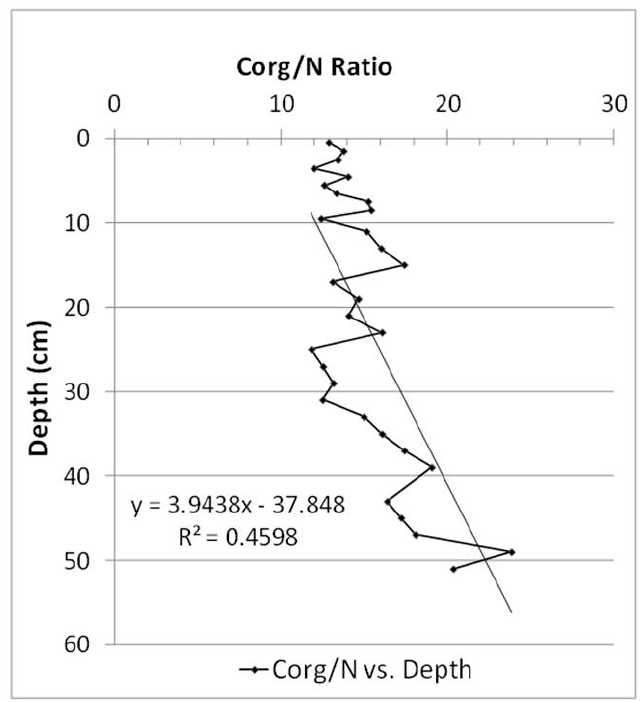
Figure 4. Downcore variation in Organic Carbon / Total Nitrogen ratio (C org / N). The trend line depicts a gradual increase in C org / N ration with increasing sediment depth.